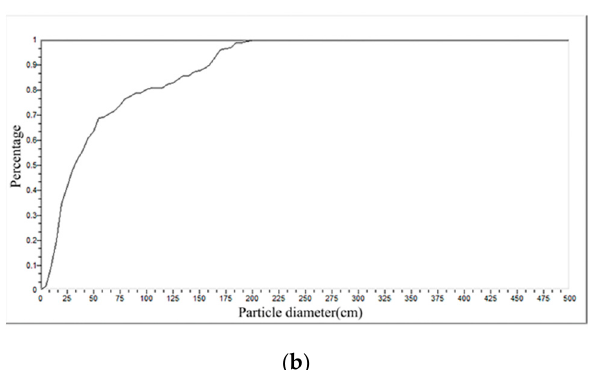
Table 6. Eleven parameter values of a typical blasting operation.